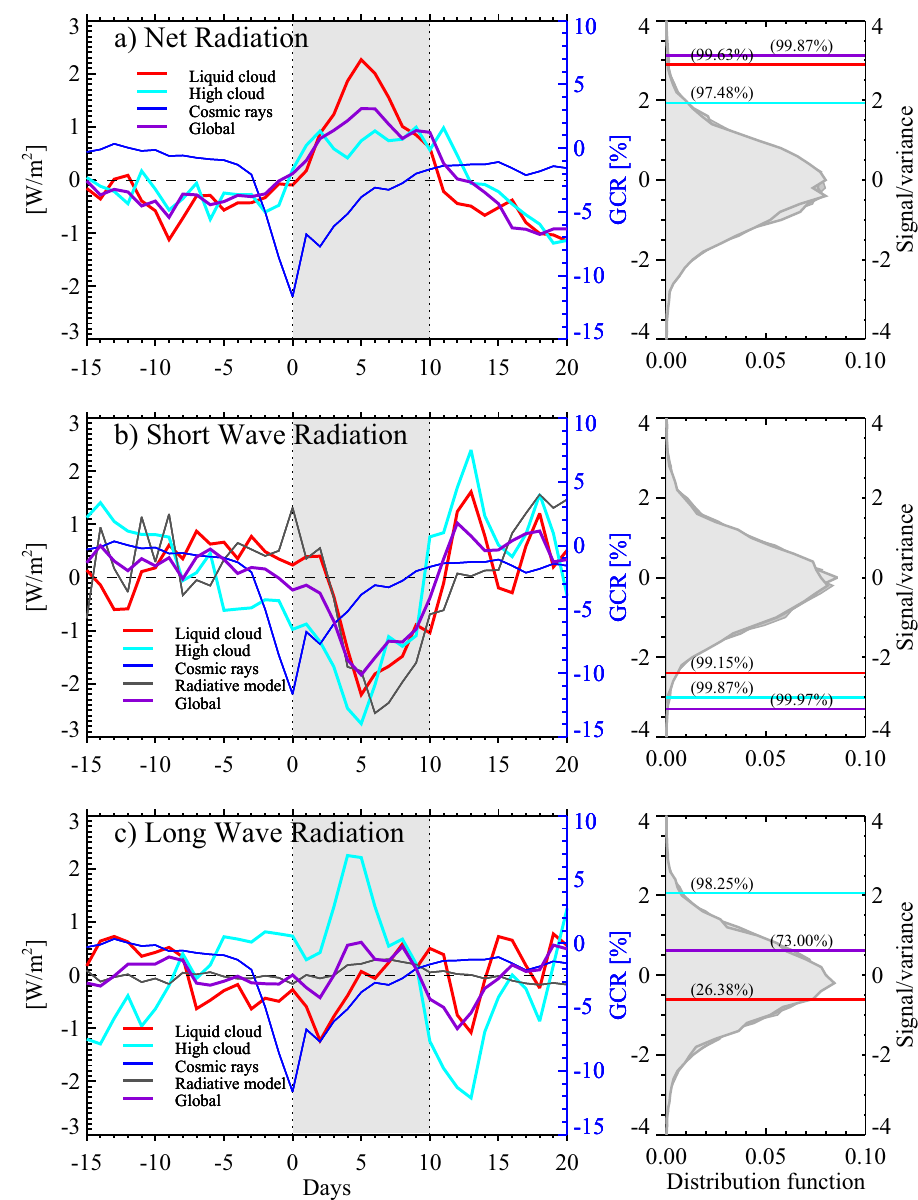
Figure 1. The top of atmosphere radiative balance (relative to the mean of the time series, left column) from CERES data superposed for the five strongest FDs since 2000. The panel (a) is the change in net radiative forcing for three situations: geographical areas with predominantly, (1) liquid clouds (red curve), (2) areas with high clouds (cyan curve), (3) and global averages (purple curve). The gray area signifies the period used to integrate the response (day 0–10). The blue curve is the variation in cosmic rays as measured by the Oulu neutron monitor. Right-hand columns are bootstrap distribution functions of the integrated signal. The red, cyan, and purple lines denote the significance of the FD signal obtained from the three distribution functions. Panel (b) left-hand side shows changes in TOA short wave radiation for areas with liquid clouds (red curve), high clouds (cyan curve), and globally (purple curve). Results of the Fu-Liou radiative transfer model of changes in TOA SW radiative forcing obtained using the observed changes in MODIS cloud parameters are described by the gray curve. The right-hand panel (b) shows the achieved significance of the FD signals. Finally, panel (c) is the change in TOA LW radiative forcing similarly as for SW in panel (b)